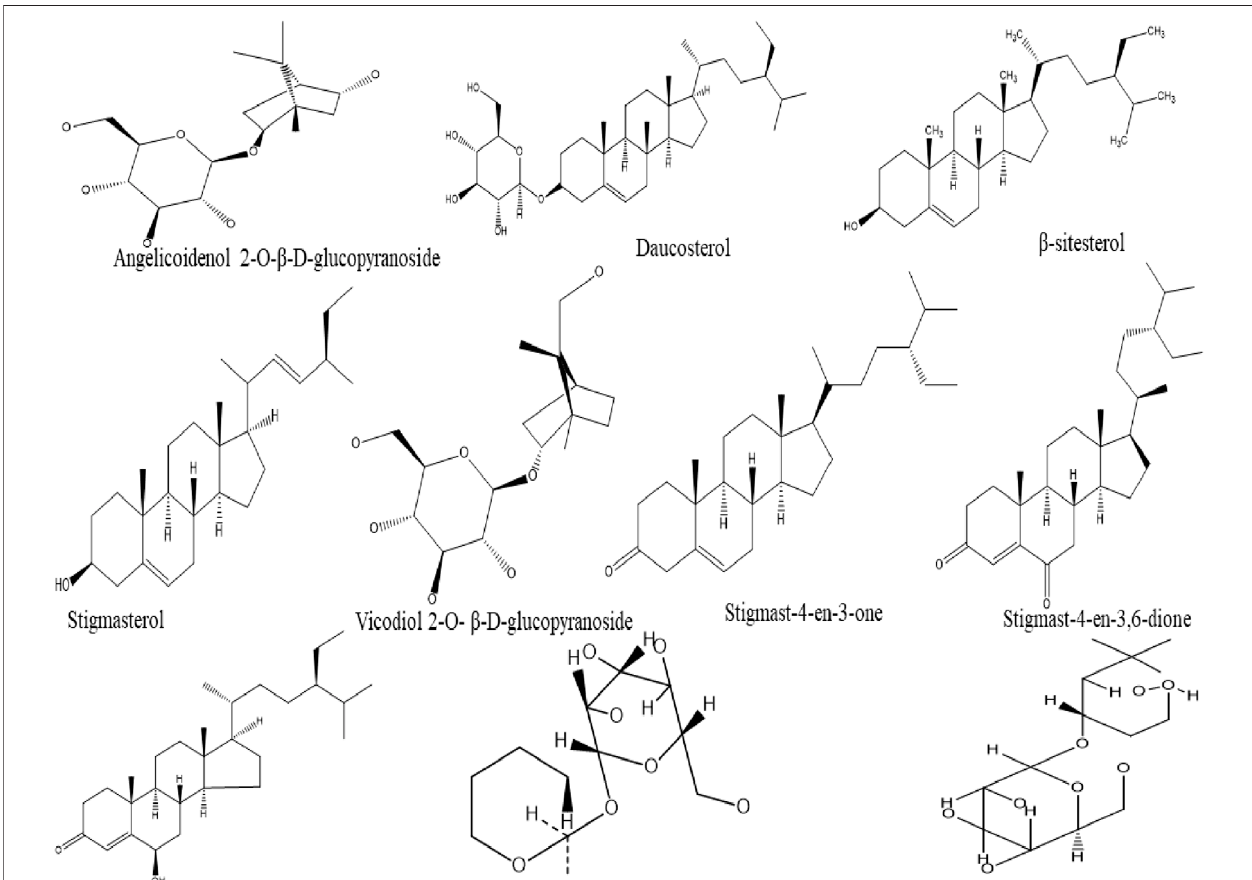
FIGURE 4 | Chemical structures of steroids and monoterpenoid glycosides compounds isolated from ginger.